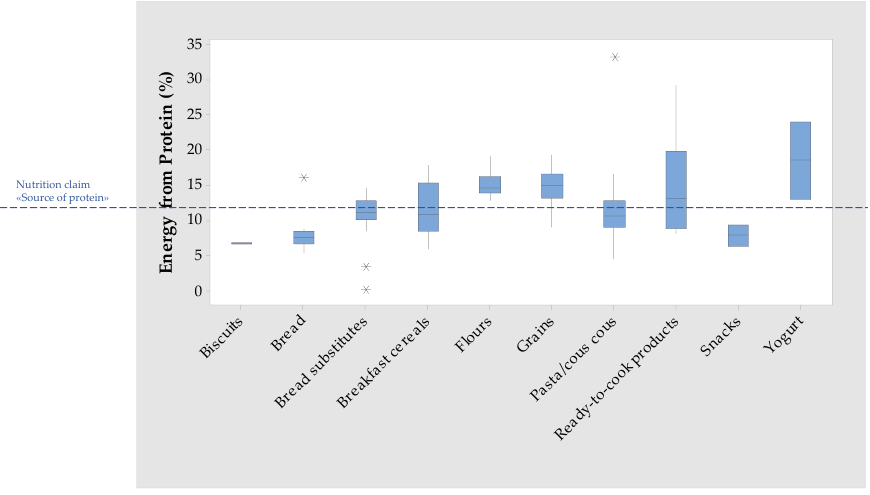
Figure 2. Boxplot for energy from protein (%) in quinoa food categories and reference value for the claim “source of protein”.